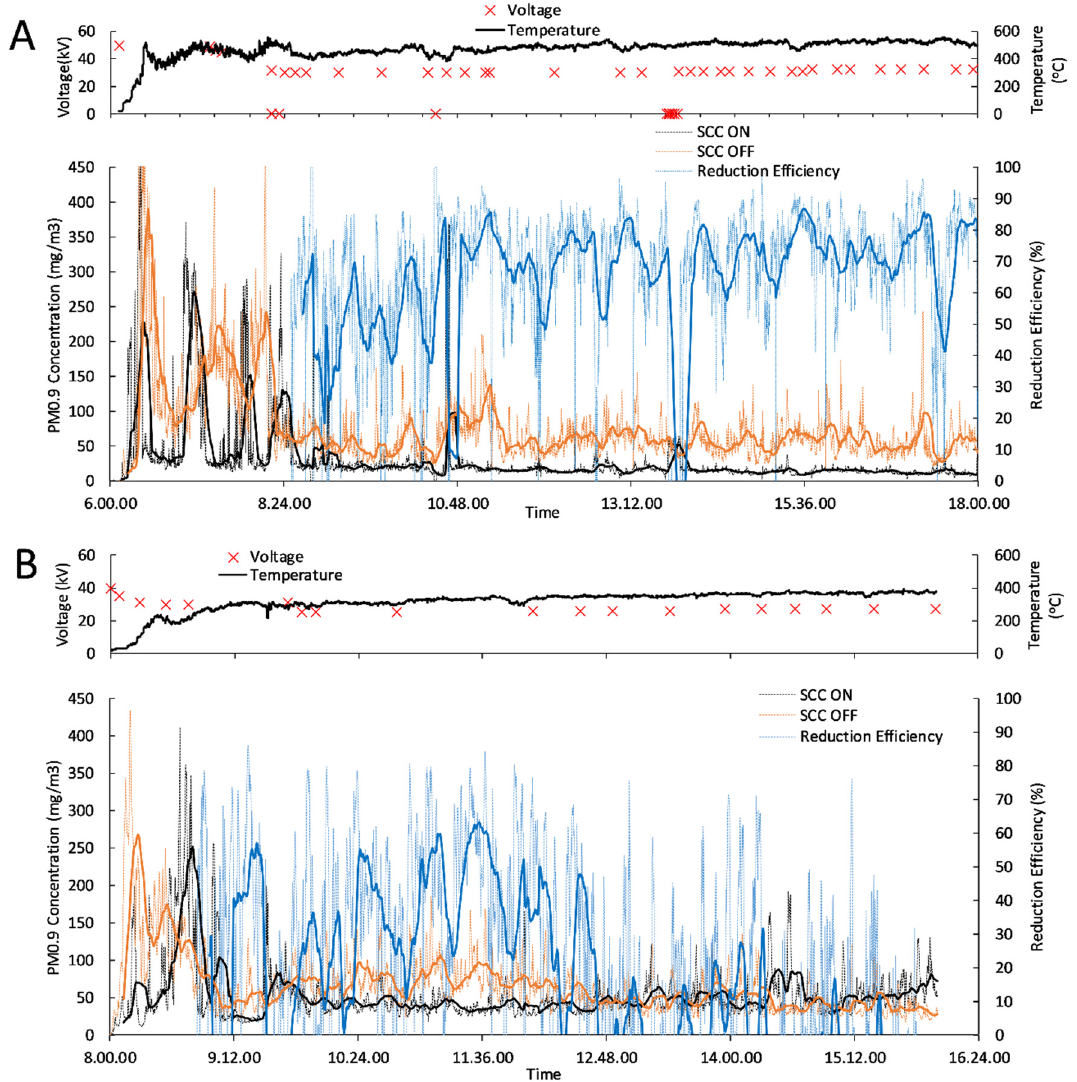
Figure 10. Shielded corona charger (SCC)-induced reduction efficiency in long-term experiment at temperature ranges of ( A ) 400–500 °C and ( B ) 300–400 °C for particulate matter PM0.9 measured by electrical low-pressure impactor (ELPI).